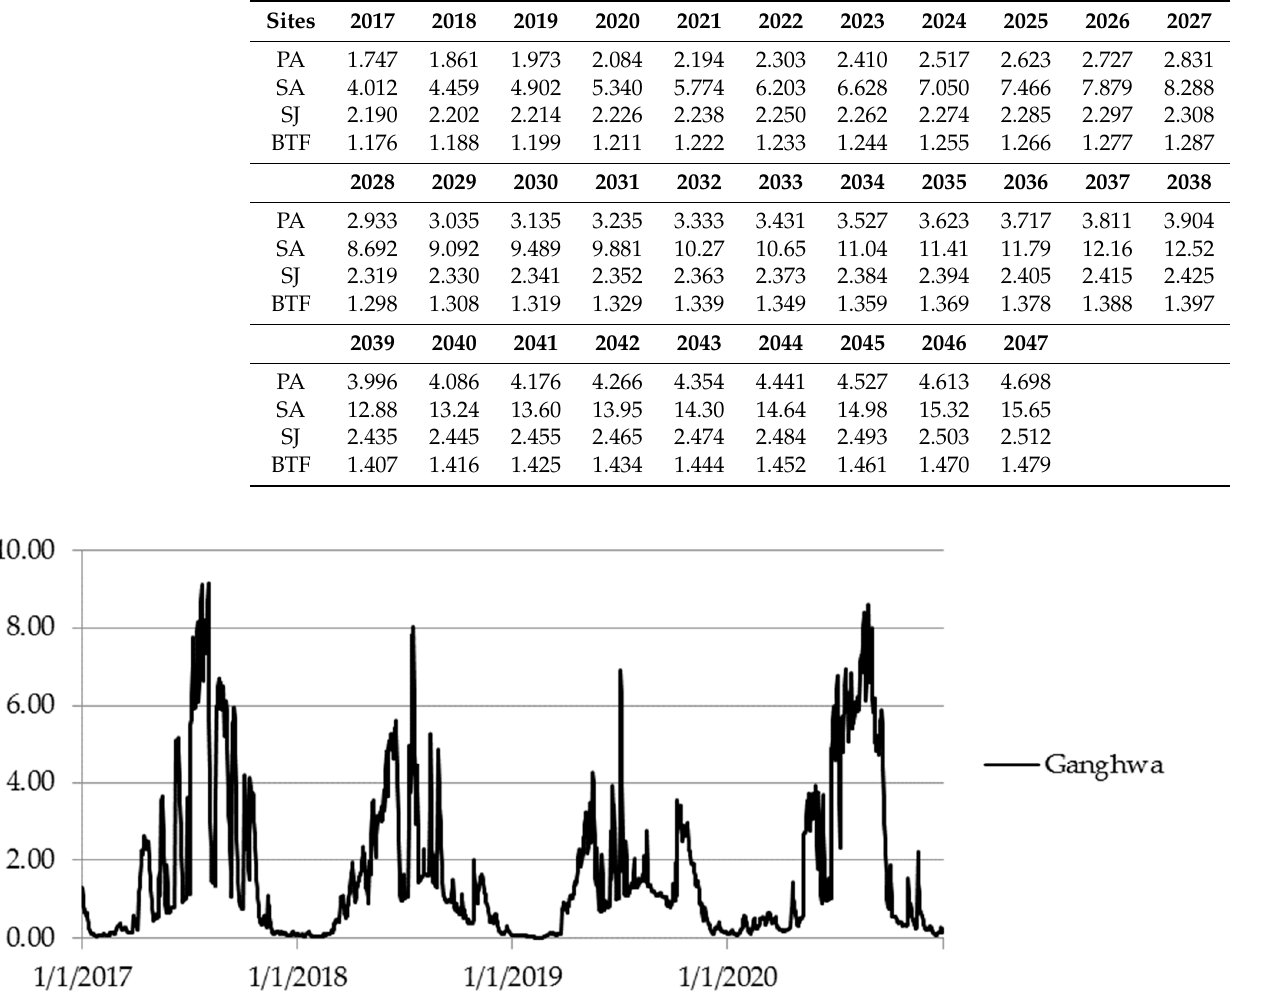
Figure A1. Mean within 4 years (2017–2020) dynamics of ∊ in Ganghwa province, Korea.